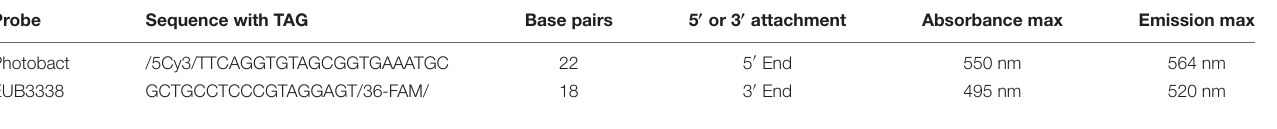
TABLE 2 | FISH probe sequences and dye used to identify Photobacterium in the samples. Probe Sequence with TAG Base pairs